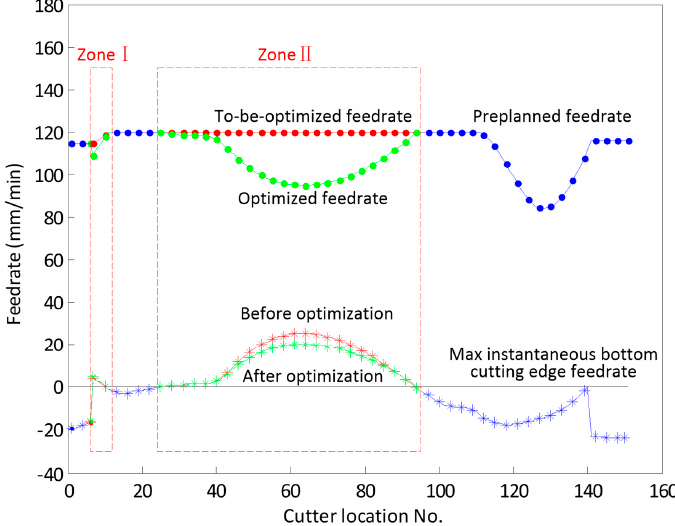
Figure 7. The bottom edge cutting is identified and the feed rates are optimized.